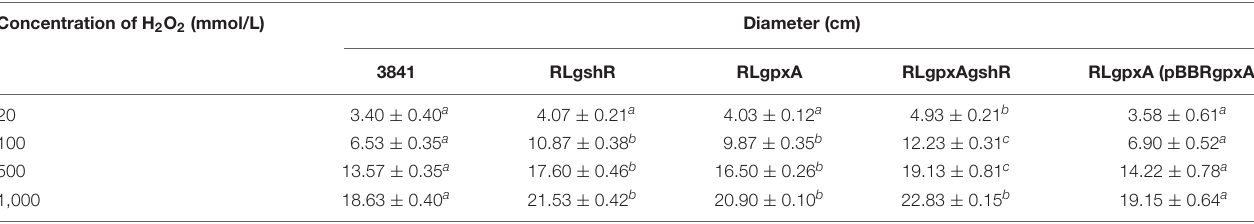
Data (mean ± SEM) are the averages of three independent experiments. a , b , c Values with different letters are significantly different from that of the wild-type RL3841 control (two-way ANOVA, P < 0.05).